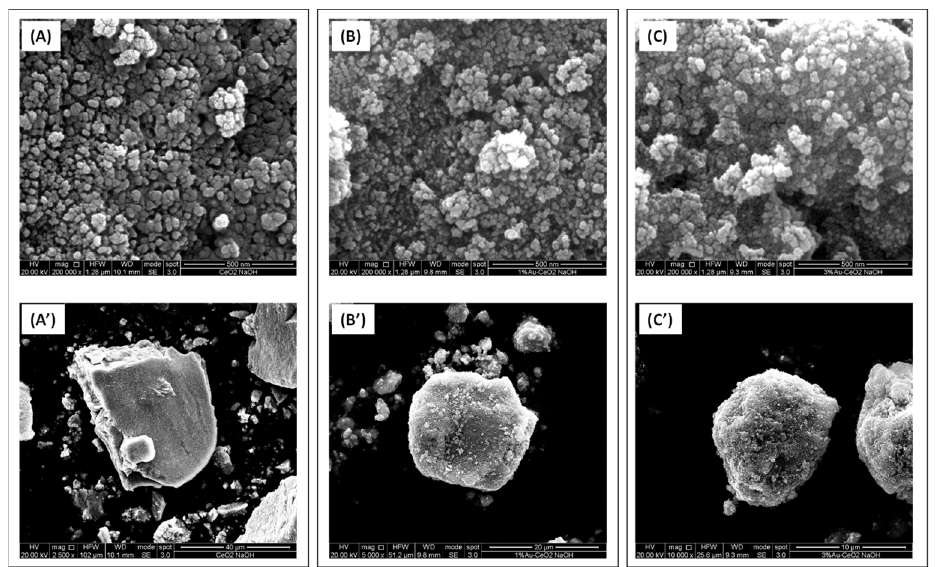
Figure 3. SEM micrographs of the prepared powders at two different magnifications for ( A , A ′ ) bare CeO 2 hp; ( B , B ′ ) 1%Au/CeO 2 hp and ( C , C ′ ) 3%Au/CeO 2 hp.